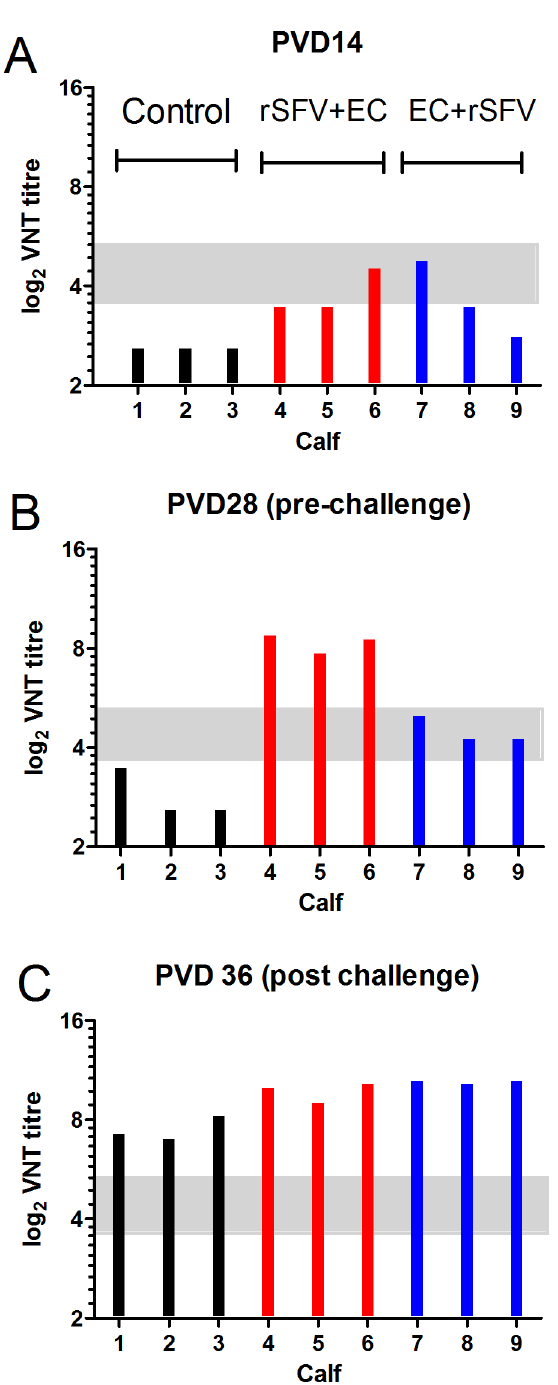
Fig 7. Production of neutralizing anti-FMDV antibodies in cattle. Sera from the calves in group 1 (C1-C3, black bars, control), group 2 (C4-C6, red bars, vaccinated with rSFV-FMDV-P1-2A-mIRES-3C on PVD 0 followed by empty capsids on PVD 14) and group 3 (C7-C9, blue bars, vaccinated with empty capsids on PVD 0 followed by rSFV-FMDV-P1-2A-mIRES-3C on PVD 14) were collected during the experiment 3. All animals were challenged with FMDV on PVD 28. Samples from PVD 14 (A), PVD 28 (B) (prior to challenge) and PVD 36 (C) (post challenge) were assayed for the presence of neutralizing anti-FMDV antibodies using VNTs. Results were calculated as reciprocal VNT titres and are displayed as log 2 values. VNT titres (cid:1) 11 (log 2 11 = 3.459) are considered negative while titres (cid:3) 45 (log 2 45 = 5.492) are considered positive. Intermediate titres are considered as inconclusive (indicated within grey